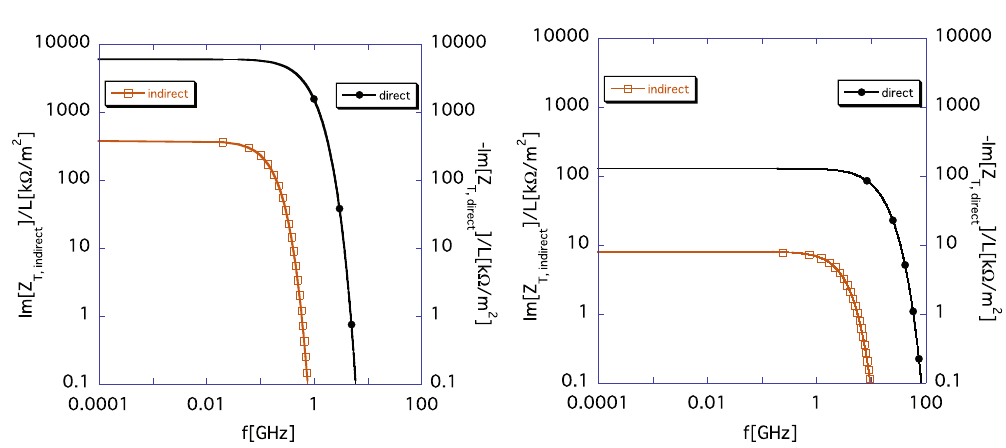
Figure 1. Difference between conventional formula (1) (brown) and new formula (51) (black) for different Lorentz- β . The left and the right panels show the imaginary parts of the impedance for β = 0.1 and 0.9, respectively.